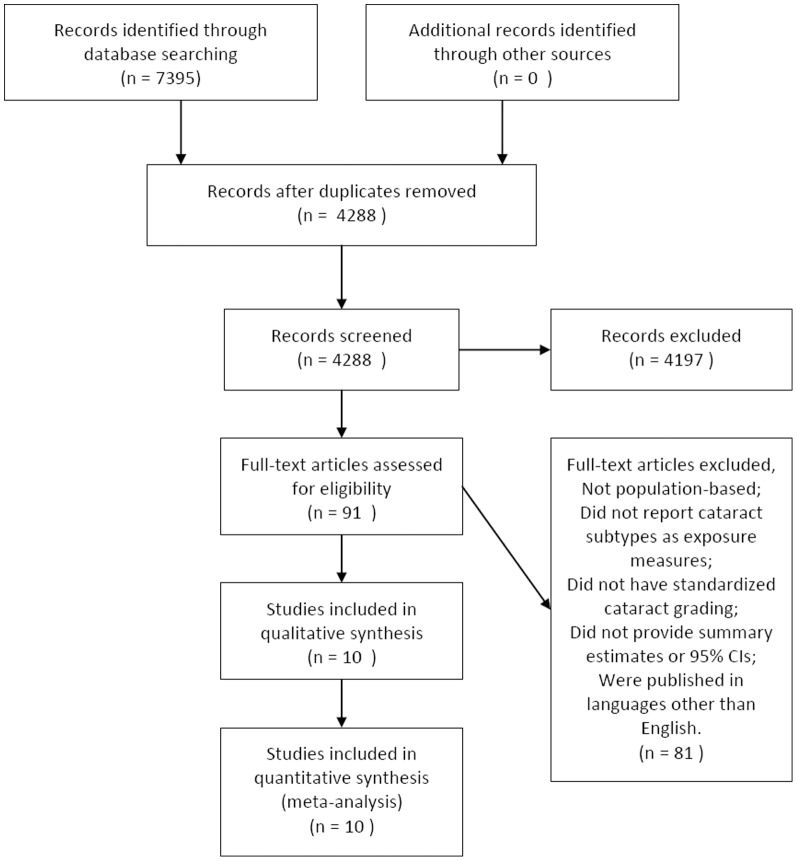
Flow diagram showing the selection process for inclusion of studies.